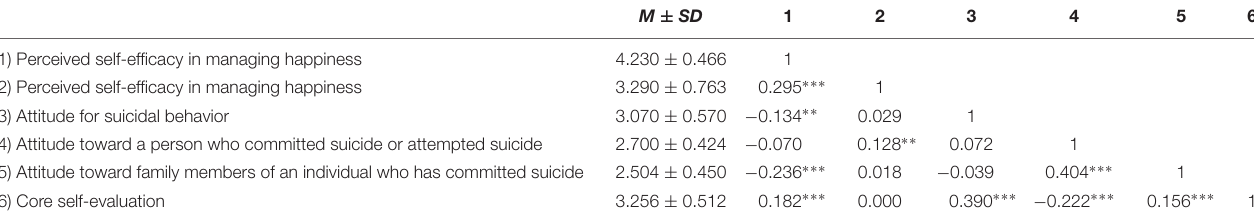
TABLE 1 | The correlation based on perceived self-efficacy in managing happiness and curiousness.